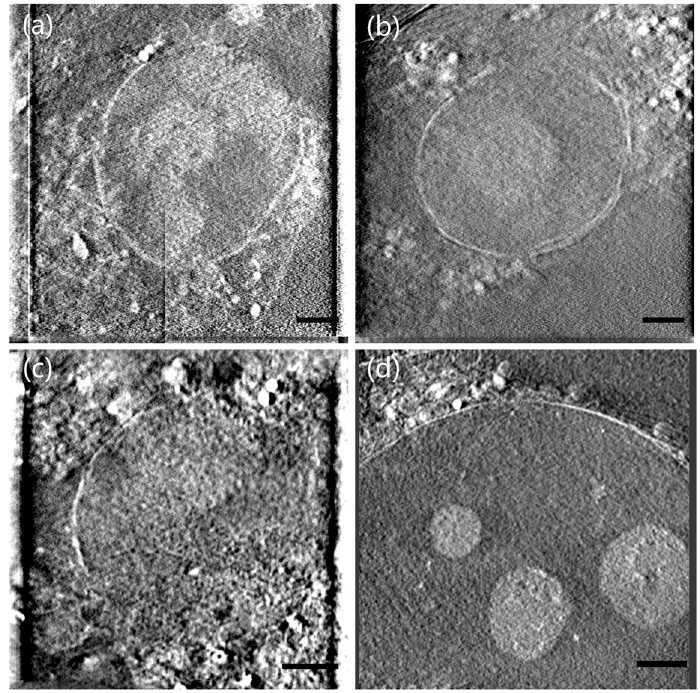
Figure 6. Reconstructed slices of HeLa cells. ( a , b ) slices of two apoptotic cells in Figure 4a; ( c ) slices of necrotic cell in Figure 4d; ( d ) slices of normal cell in Figure 4e. Scale bar 2 μ m.